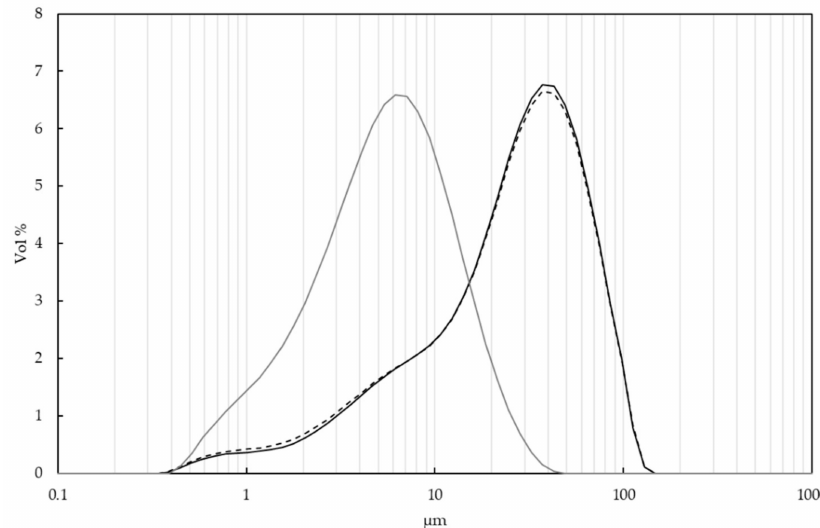
Figure 4. Particle size distribution of glacial rock flour (GRF) primary particles (grey line), T1 (solid black line), and T2 (dashed black line). The distributions were constructed as an average of five replicates measured five times using a Malvern Mastersizer 2000. No error bars are shown, as the standard deviations were small and concealed the small di ff erence between T1 (control) and T2.